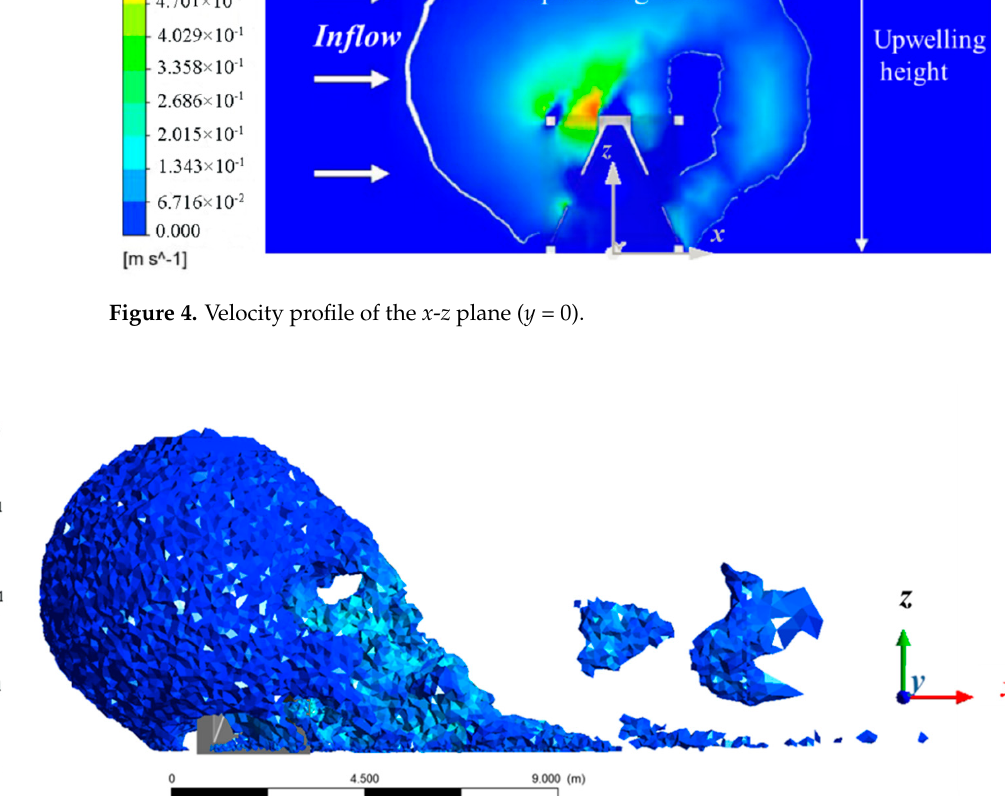
Figure 5. Upwelling volume.